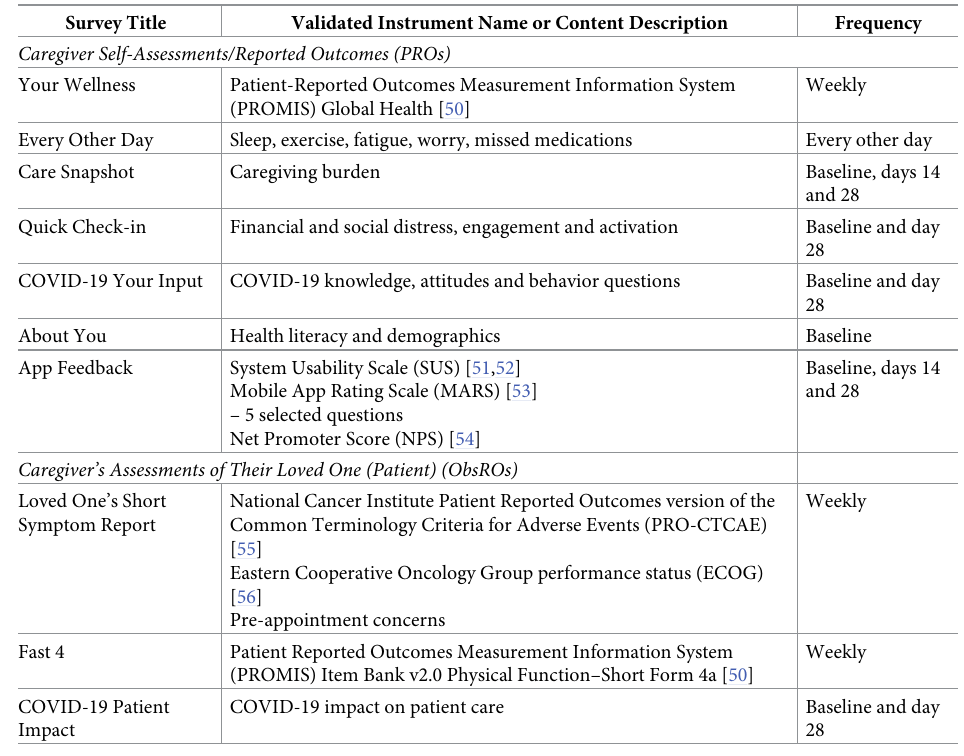
Table 1. Surveys included in the TOGETHERCare